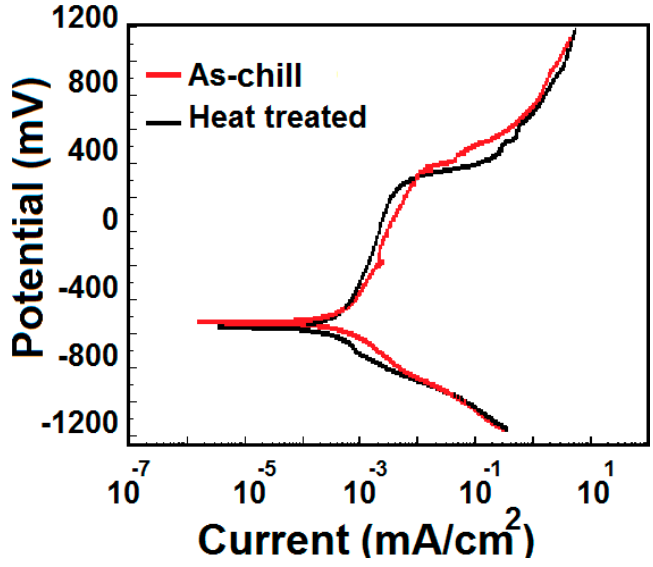
Figure 10. Fractography of Co ‐ 20 wt. % Cr alloy: ( a ) in the as ‐ chill cast condition and ( b ) heat ‐ treated condition.